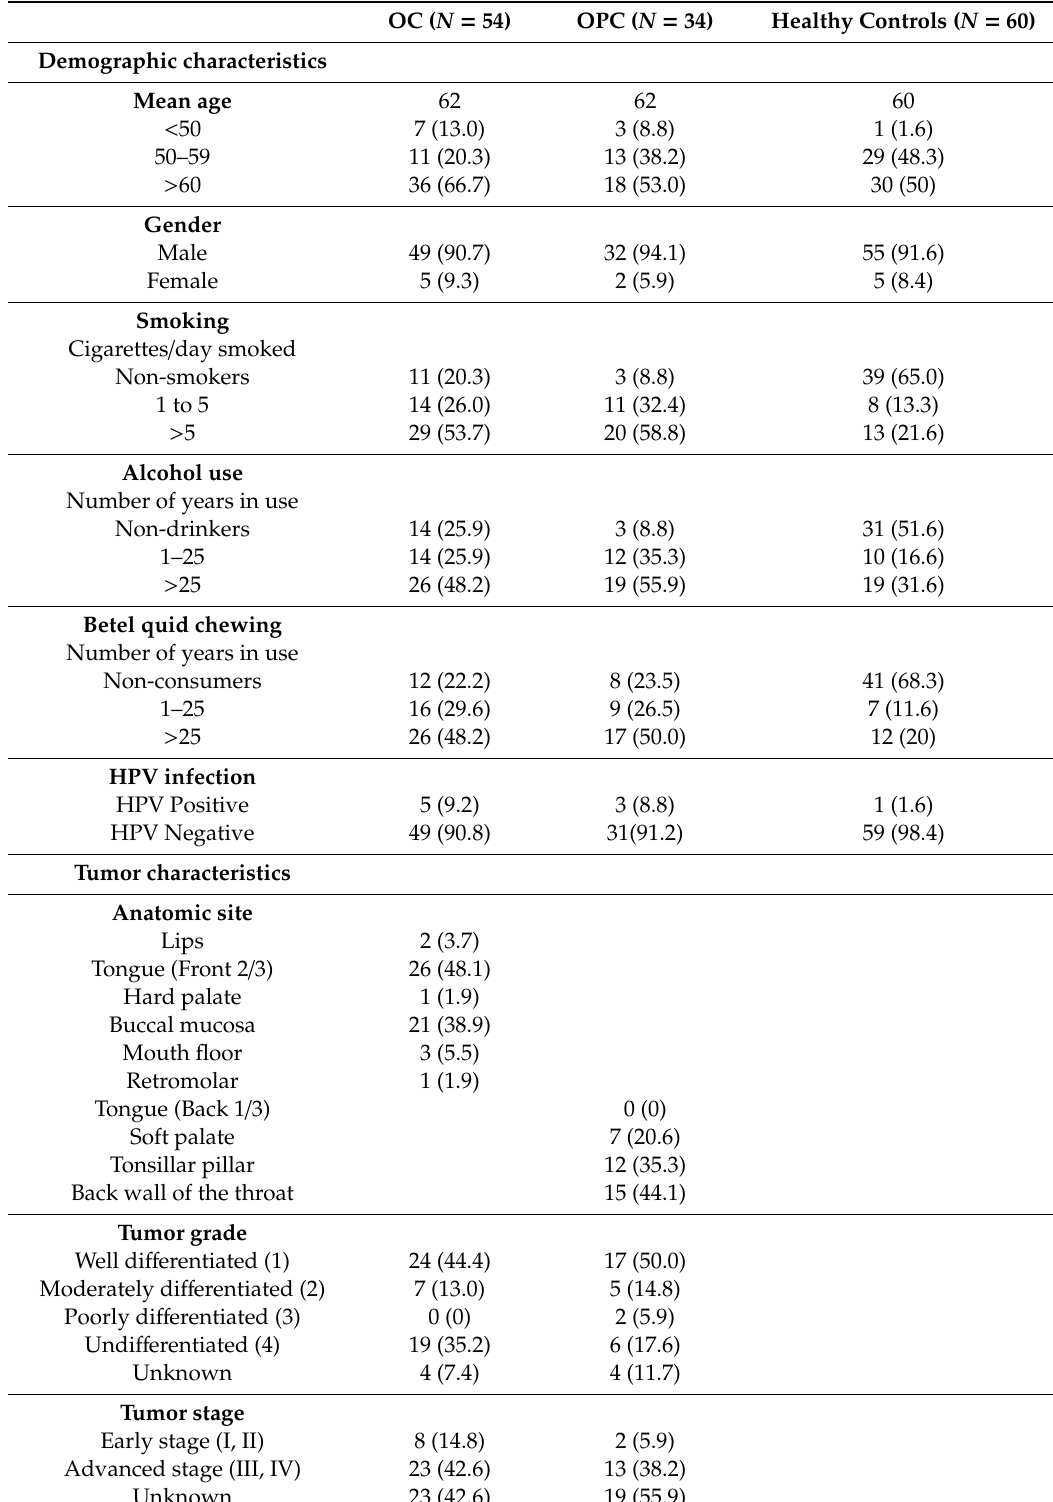
Table 2. Socio-demographic and tumor characteristics of the study